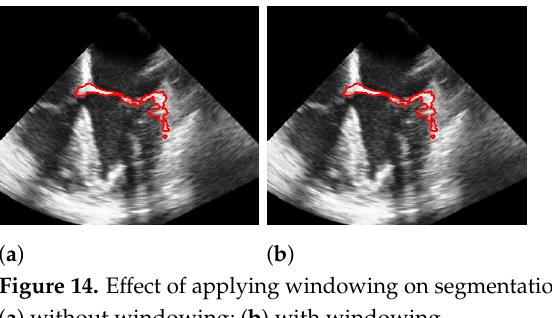
Figure 14. Effect of applying windowing on segmentation. The red marks indicate the segmentation. ( a ) without windowing; ( b ) with windowing.